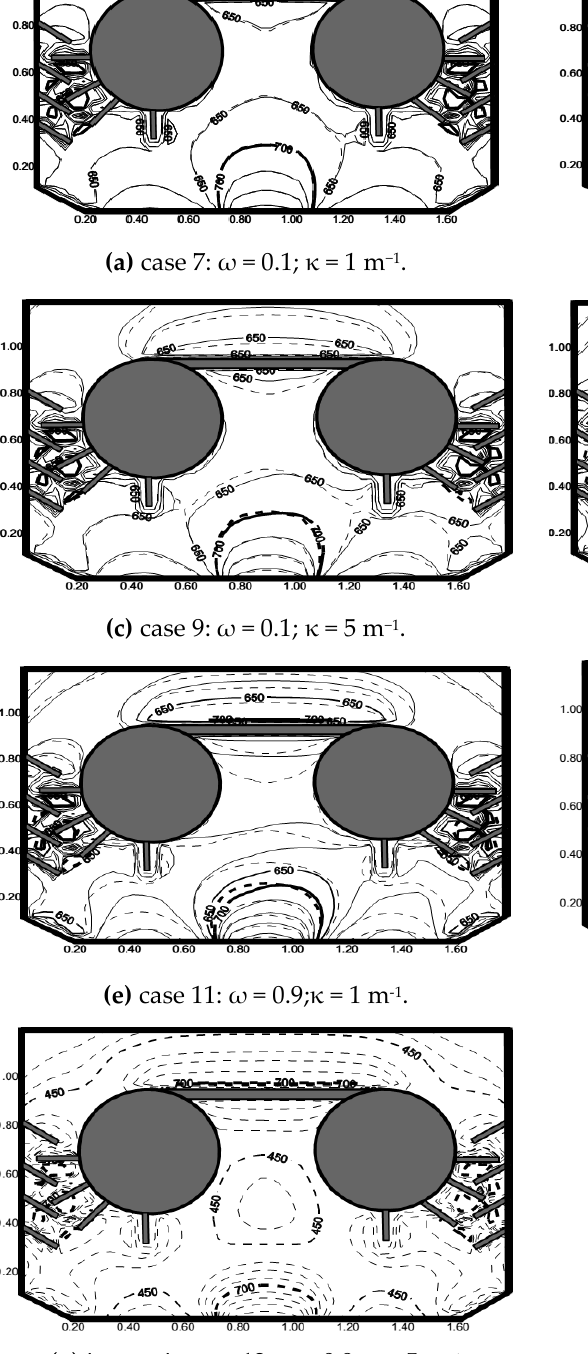
Figure 7. Effects of the absorption and albedo coefficients on the medium temperature pattern: Comparison between the isotropic case and F1 function. Dashed lines: Isotropic, continuous lines: carbon. ( a ) case 7: ω = 0.1; κ = 1 m − 1 , ( b ) case 8: ω = 0.1; κ = 5 m − 1 , ( c ) case 9: ω = 0.1; κ = 5 m − 1 , ( d ) case 10: ω = 0.5; κ = 5 m − 1 , ( e ) case 11: ω = 0.9; κ = 1 m -1 , ( f ) F1 function case 12: ω = 0.9; κ = 5 m − 1 , ( g ) isotropic case 12: ω = 0.9; κ = 5 m − 1